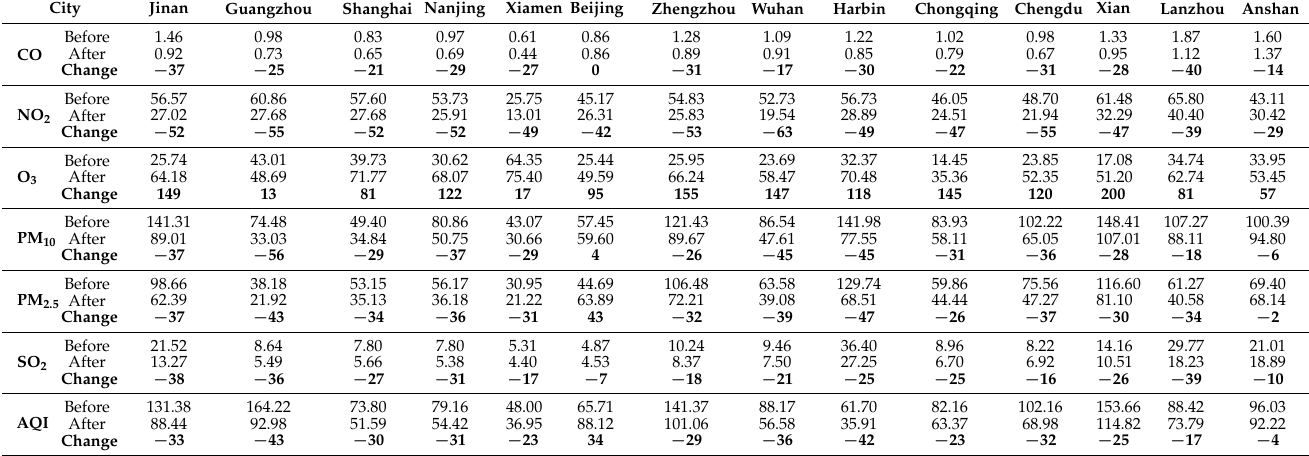
Table 1. Temporal change in air pollutants of 14 cities of China before (4 December 2019 to 22